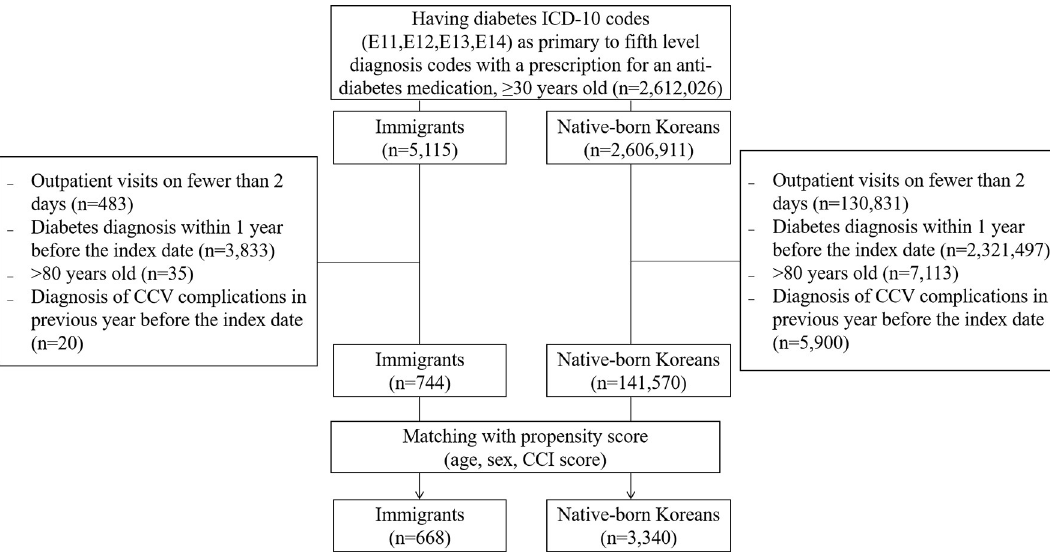
Fig 1. Flow diagram of selection of study